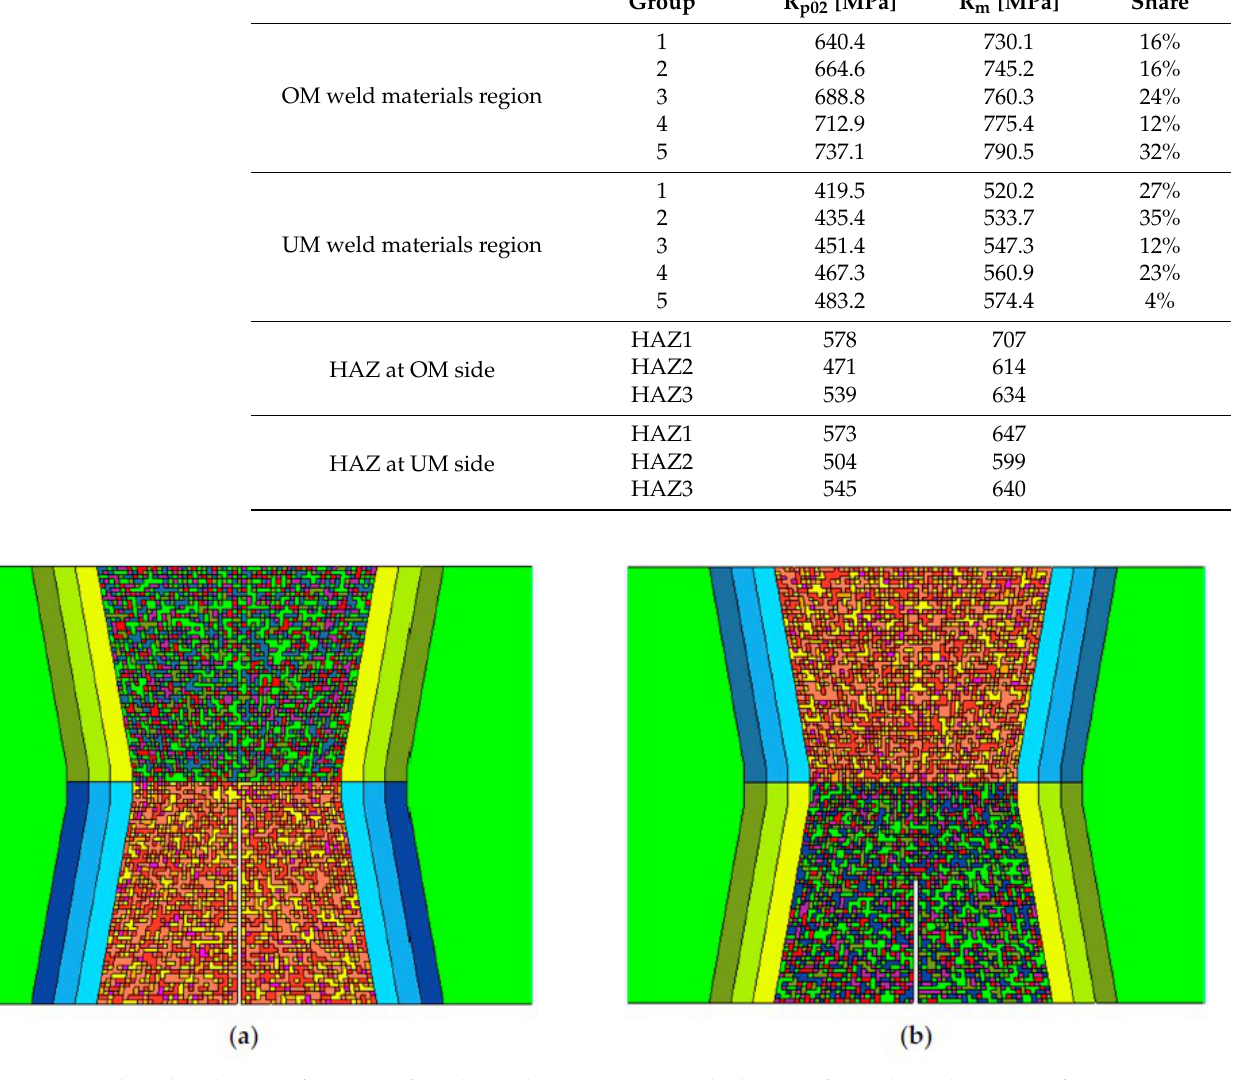
Figure 9. Random distribution of 5 group of mechanical properties in mesh elements for both combinations of specimens: ( a ) UM/OM configuration 1 (initial crack in UM); ( b ) OM/UM configuration 2 (initial crack in